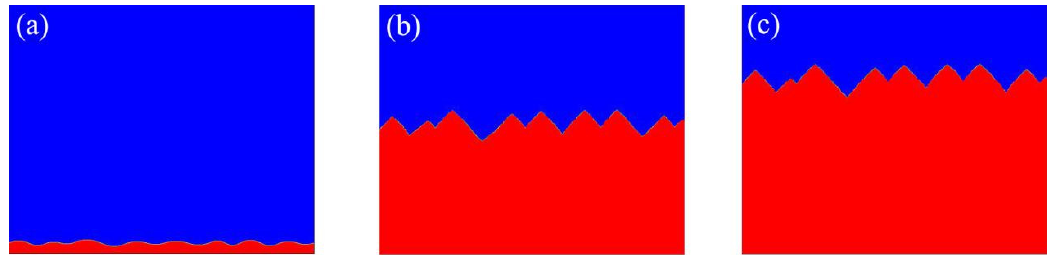
Figure 3. Evolutions of interface morphologies for v e = 241 µ m/s in the domain of 613 µ m × 500 µ m :